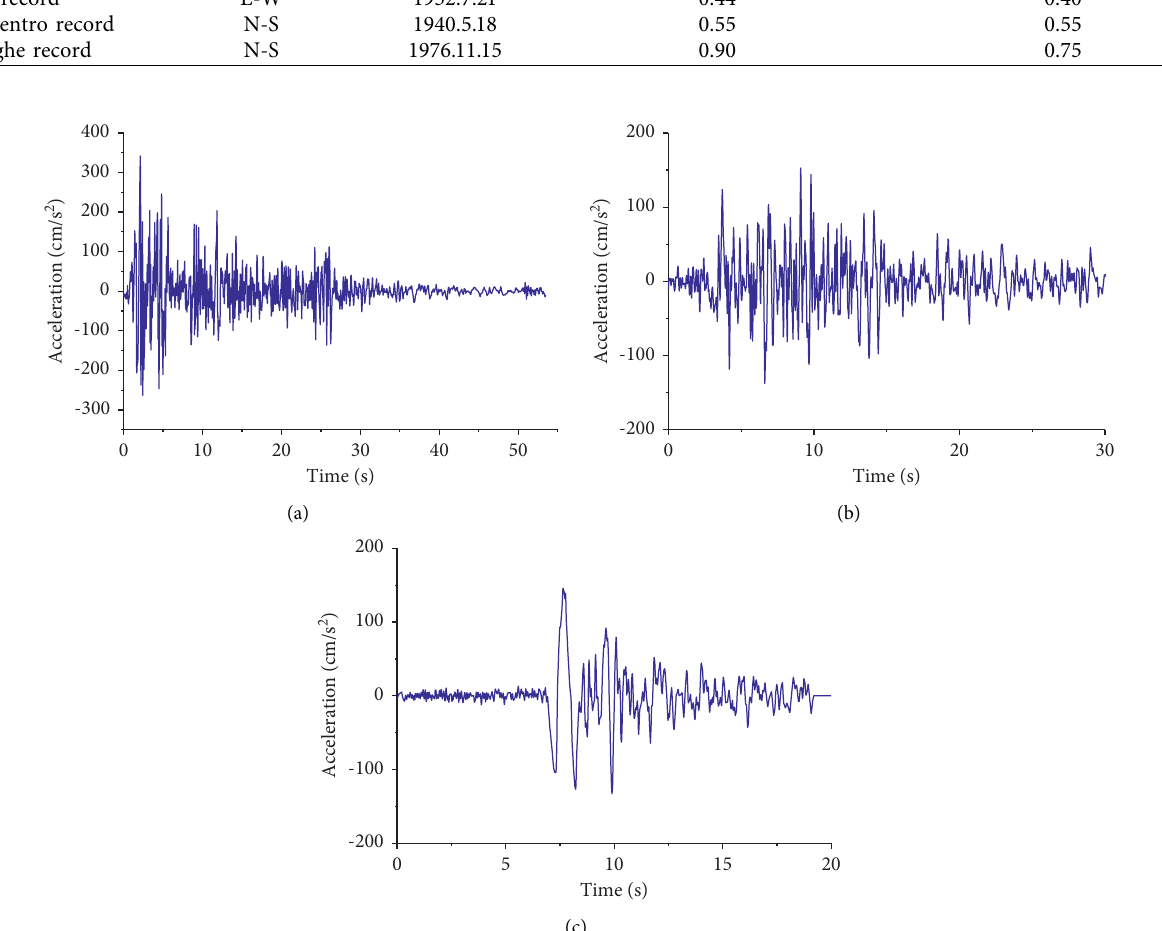
Figure 8: Acceleration time-history curves of earthquakes. (a) El-Centro record. (b) Taft record. (c) Ninghe